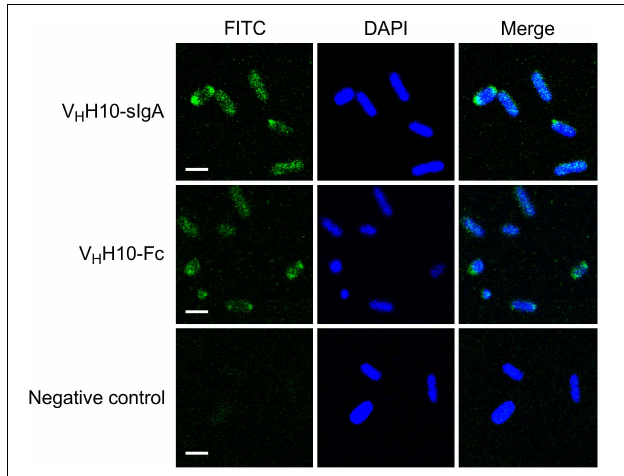
FIGURE 8 | Plant-produced V H H10-Fc chain binds to E. coli O157:H7 by itself as well as when co-expressed with the JC and SC as a sIgA complex. Shown are confocal images visualizing co-localization of a FITC-conjugated antibody that hybridizes to the Fc chain of either V H H10-sIgA (V H H10-Fc/SC/JC) or V H H10-Fc as well as DAPI that stains E. coli O157:H7 bacterial cells. E. coli cells treated with PBS-T instead of antibody were used as a negative control. Merge image represents an overlay of signals from both green and blue channels used for localization of antibodies and E. coli cells, respectively. Bar, 2 µ